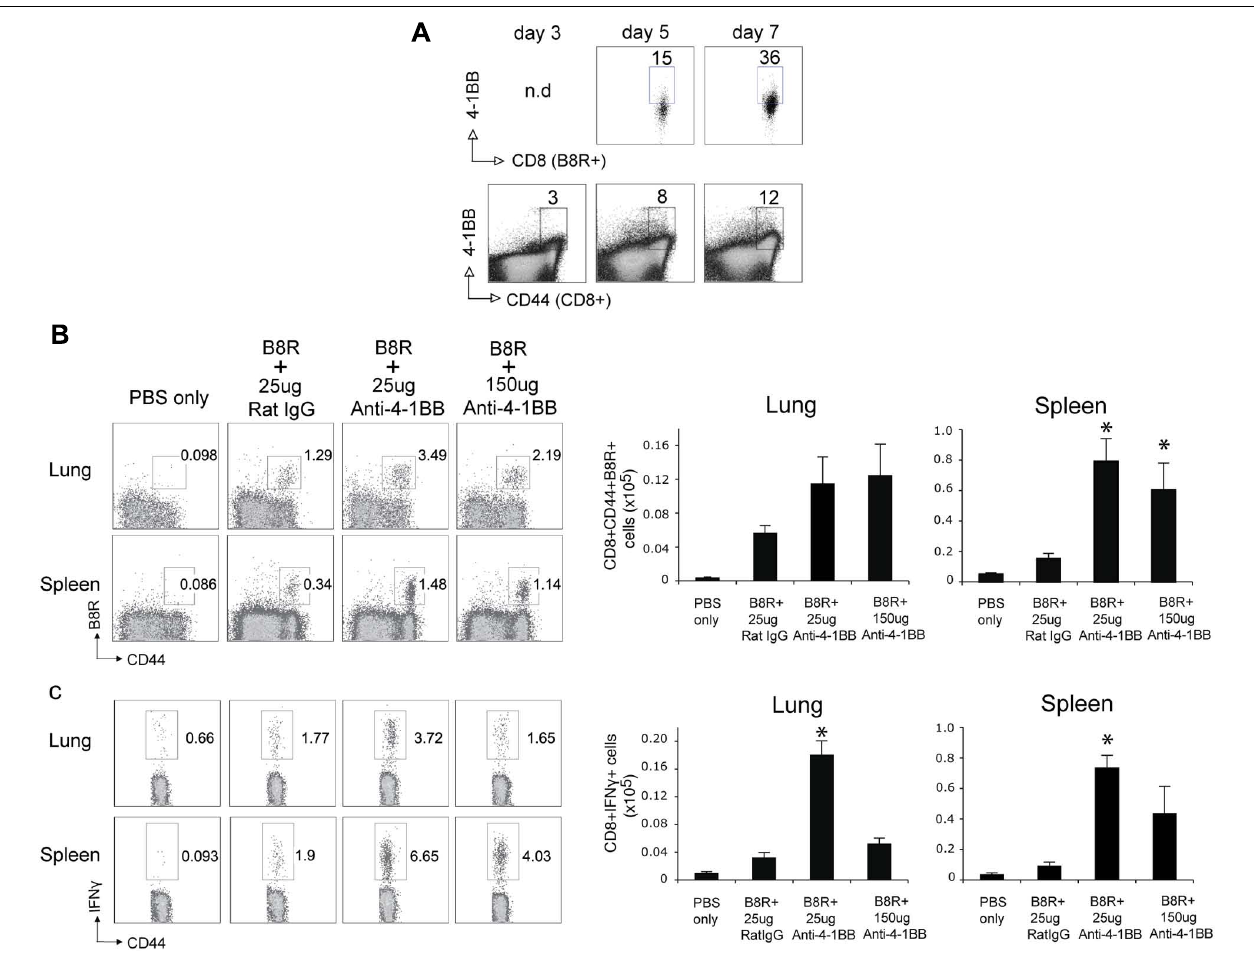
FIGURE 5 | Anti-4-1BB promotes the accumulation of memory CD8T cells followingVACV peptide immunization. WT mice were immunized s.c. at the base of the tail with 2 μ g of B8R peptide in IFA and 1 day later treated with 25 or 150 μ g anti-4-1BB or control Rat IgG. Control groups received adjuvant but no peptide and antibody (PBS). (A) Gated CD8 + CD44 + cells and B8R-tetramer-positive CD8 + cells in spleens were stained for 4-1BB on days 3, 5, and 7 post-immunization. (B,C) Three weeks after immunization: (B) cells from lung and spleen were stained with anti-CD8, -CD44, and B8R-tetramer.